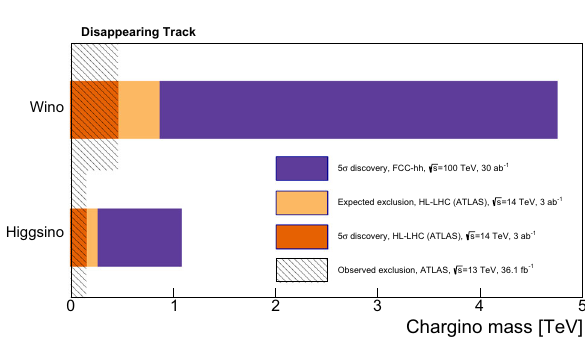
Fig. 7 Summary of reach for charginos using a disappearing-track sig- nature.TheFCC-hh5 σ -discoveryreachassumingthealternativelayout, the average number of pp interactions per bunch crossing of 500, only non-diffractive soft-QCD processes and a use of the time information of the pixel detector is shown in blue. The reach for the wino scenario is obtained by extrapolating the sensitivity curve in Fig. 6. The 5 σ - discovery reach and the 95% CL exclusion sensitivity are taken from [46]. The observed exclusion in the ATLAS search with 36 fb − 1 of Run 2 data [39,47] are shown as